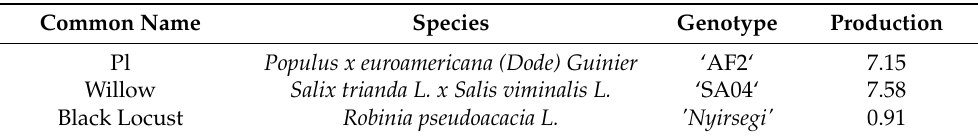
Table 2. Biomass production (t ha − 1 per year of dry matter) by